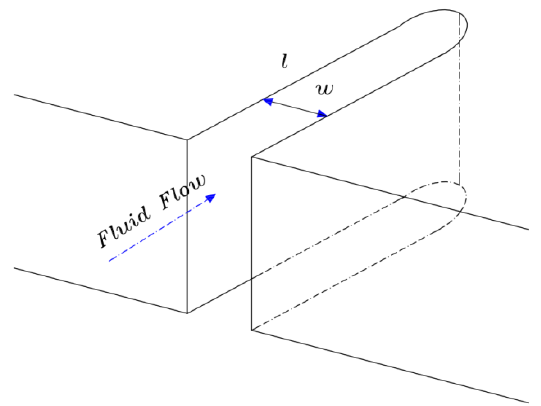
Figure 6. Structure of the KGD fracture extension in a hydraulic fracture: l is the length of fracture and w is the width of fracture.